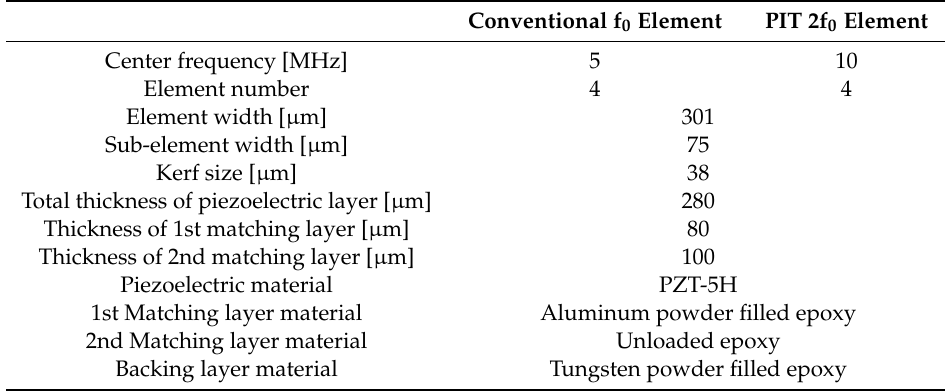
Table 1. Design specifications of the proposed transducer used in the finite element analysis (FEA)